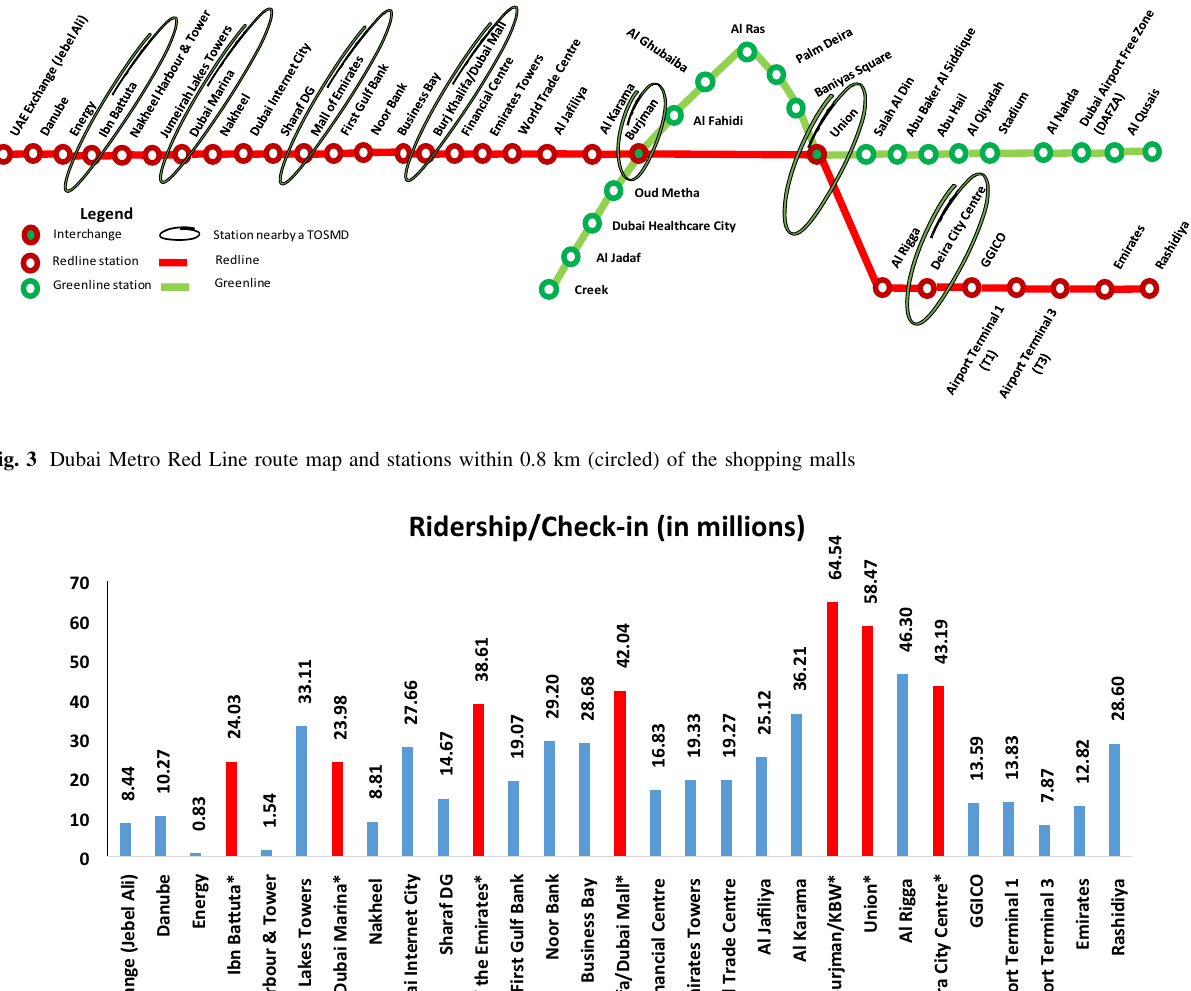
Fig. 3. It was determined that the survey period and the